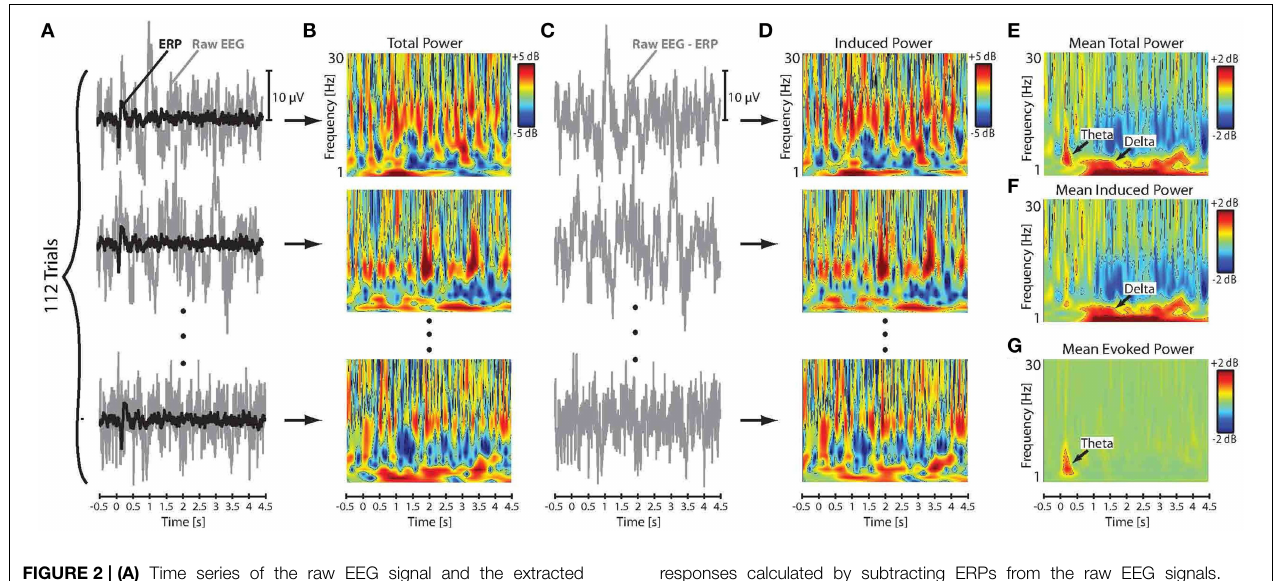
FIGURE 2 | (A) Time series of the raw EEG signal and the extracted ERP responses to downward pitch shift stimuli across 112 trials for an example AP musician subject. (B) Time-frequency maps of the log-transformed total power (evoked and induced) of the single-trial raw EEG signals. (C) Time series of the single-trial induced neural